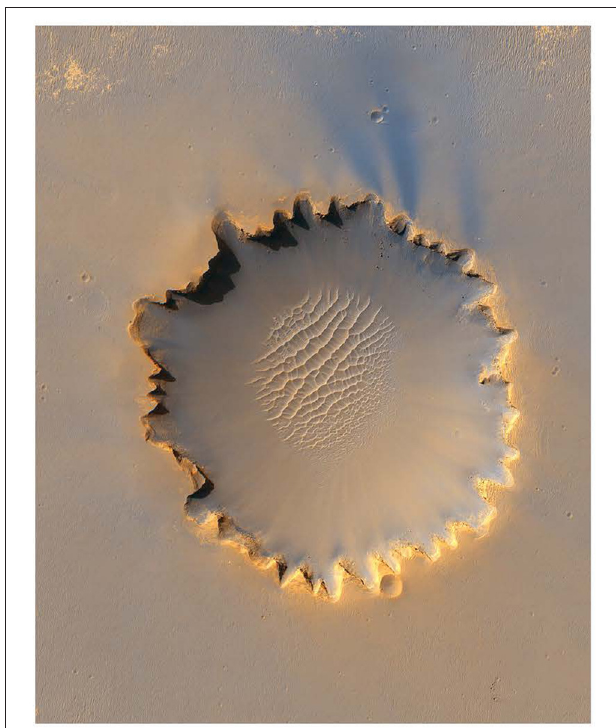
FIGURE 2 | HiRISE orbital image of Victoria Crater taken by Mars Reconnaissance Orbiter. Image credit: